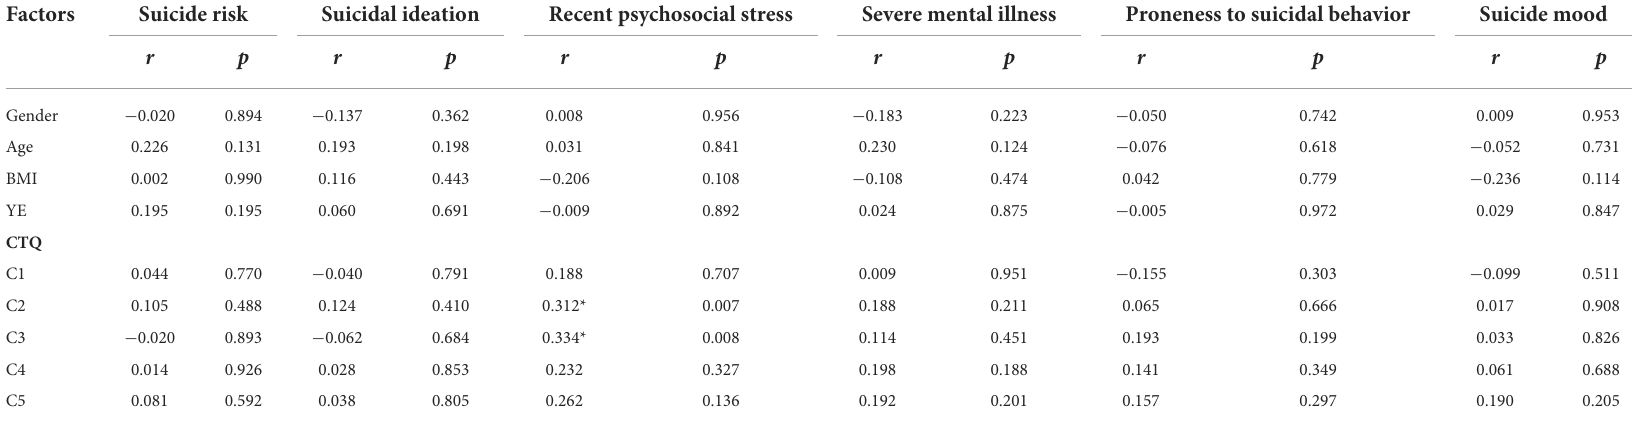
TABLE 4 Correlation between demographic and childhood trauma risks with suicide factors in the first episode